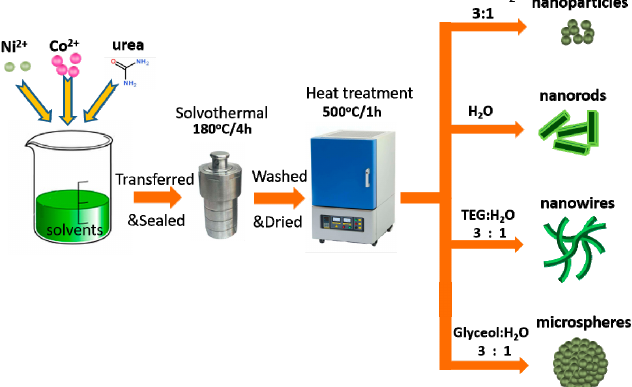
Figure 1. Scheme of the synthesis process of nickel cobaltite (NiCo 2 O 4 ) nanostructures.